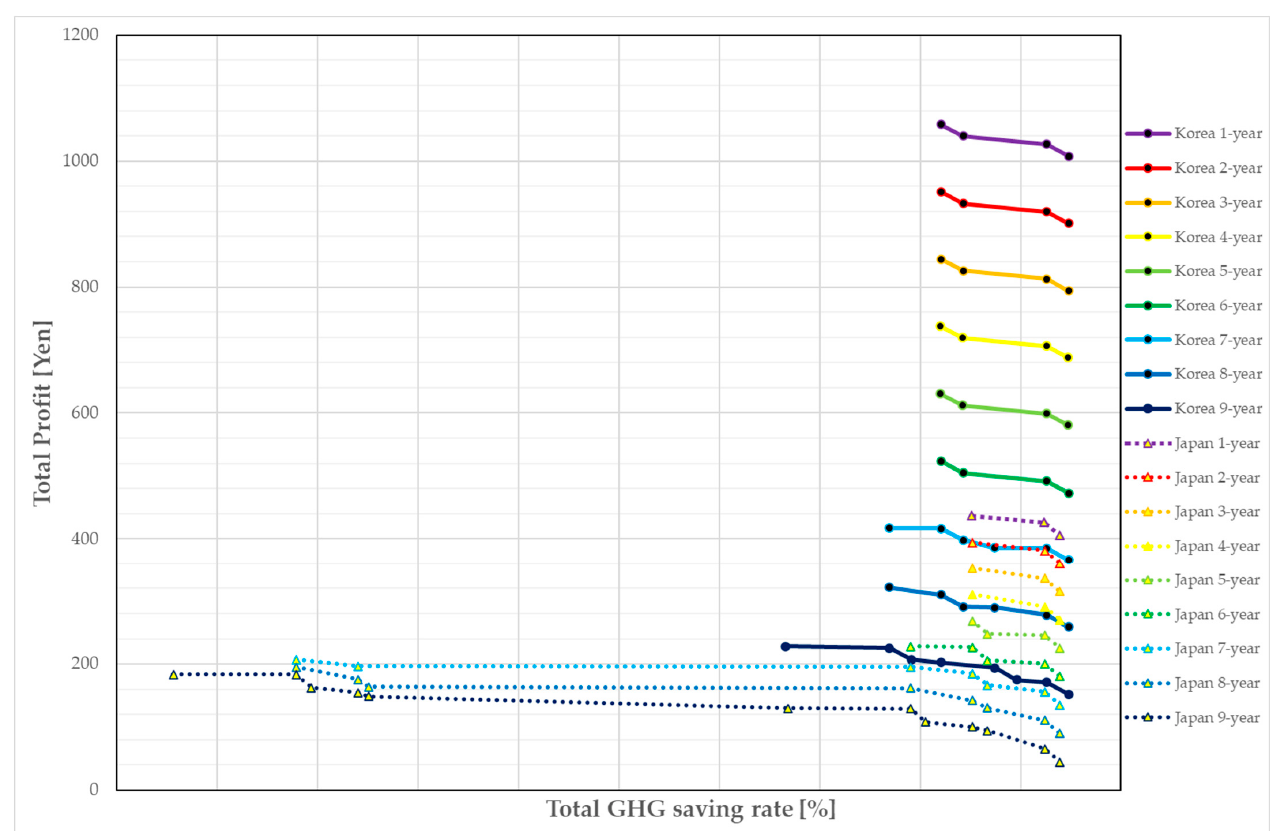
Figure 8. Comparison of the results of total GHG emissions and total profit in Korea and Japan depending on usage-year.